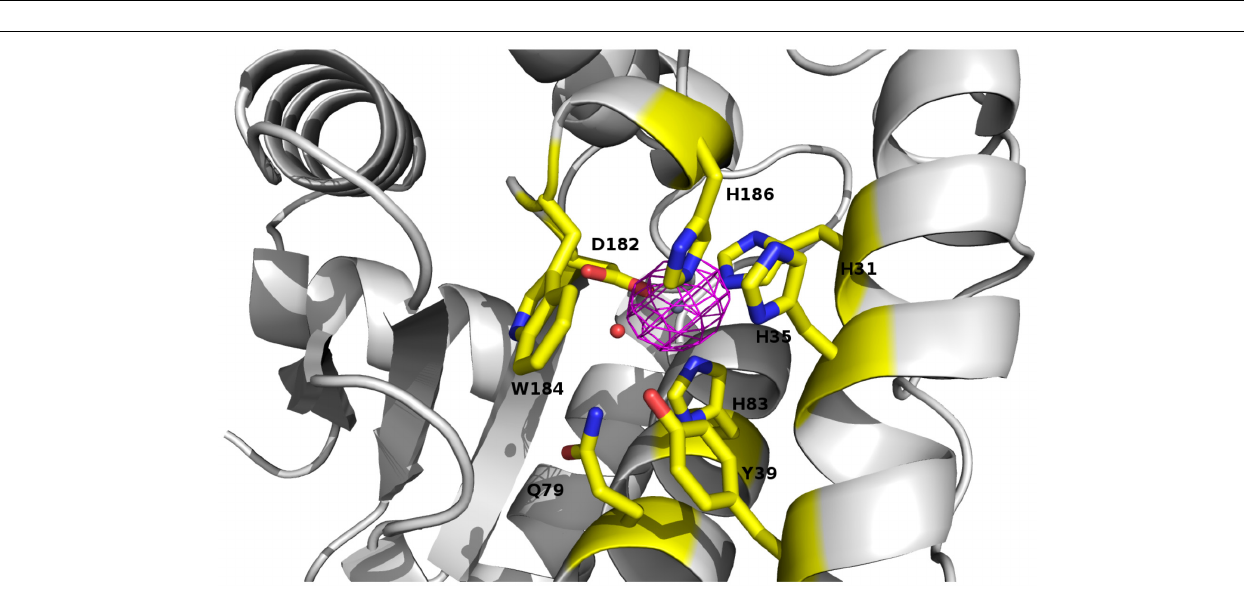
FIGURE 5 | View of the PAP9 dimer. The β -strands are drawn in arrows and the α -helices are represented in ribbons. The N-terminal domains are colored in dark pink and dark blue. The C-terminal domains are in cyan and light pink.